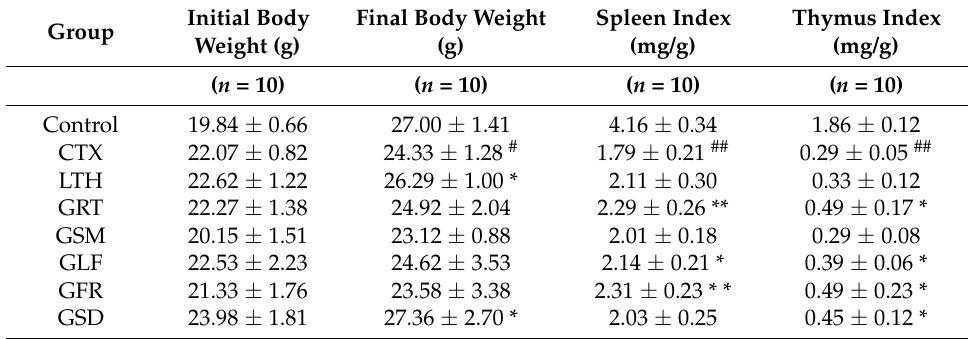
Table 1. Effect of different parts of ginseng on body weight and immune organ indices in immunosuppressed